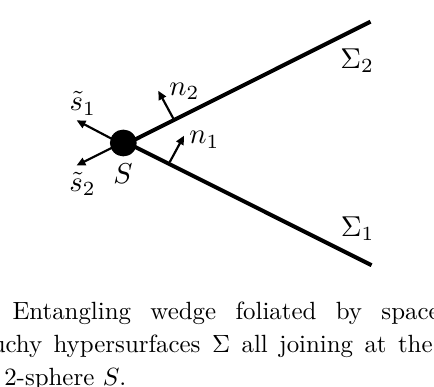
Figure 1. Cauchy surfaces Σ with boundary sphere S and associated sets of